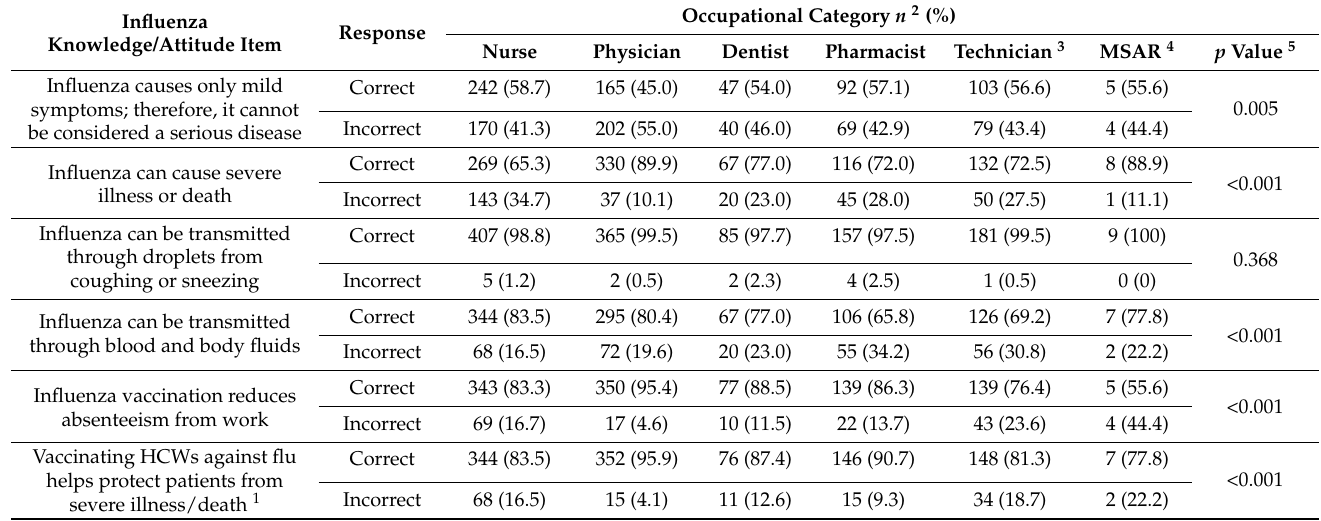
Table 2. The level of knowledge about influenza among the study respondents stratified by occu- pational category.